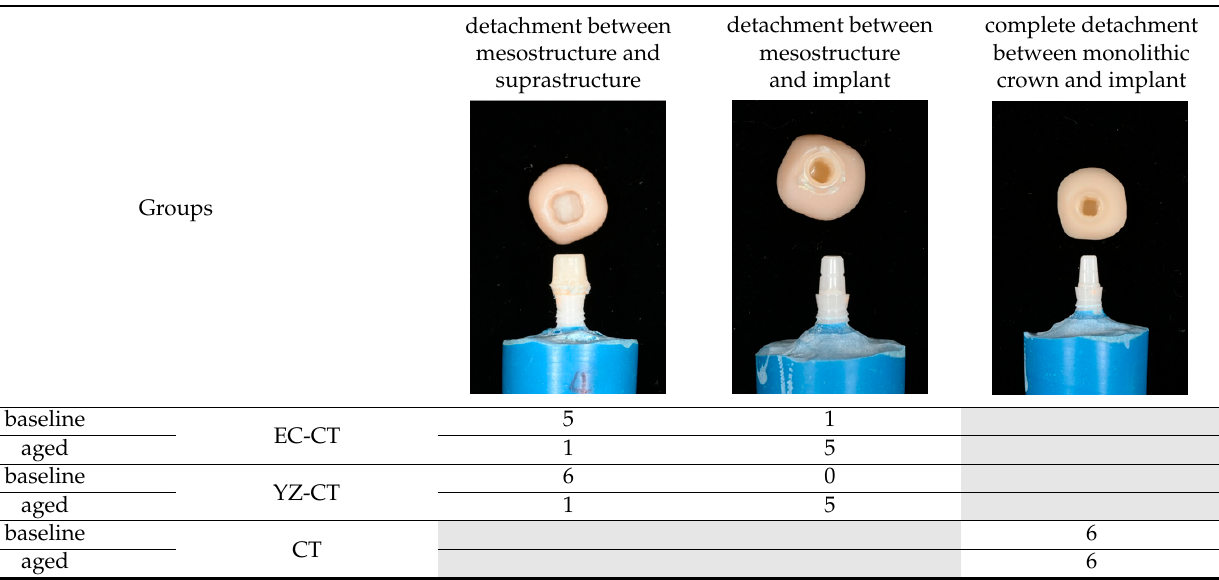
Table 7. Failure mode of the specimens under retention force testing.